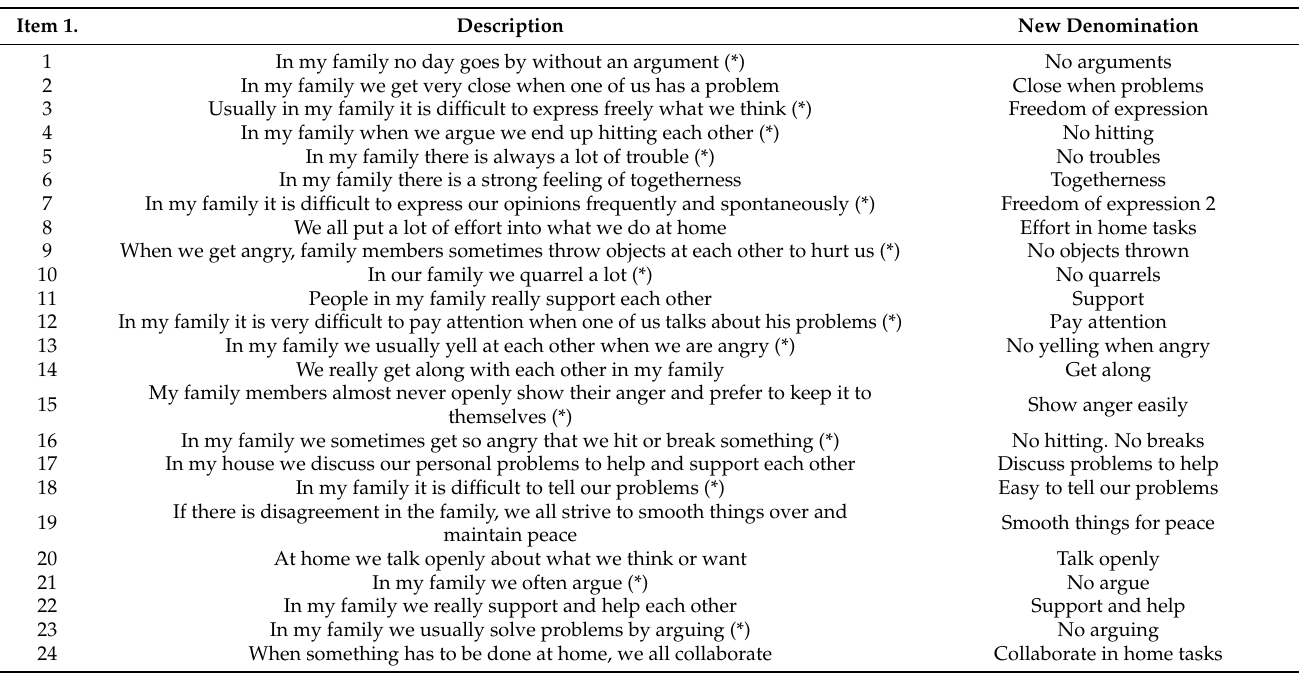
Table A1. Items denomination for tables of